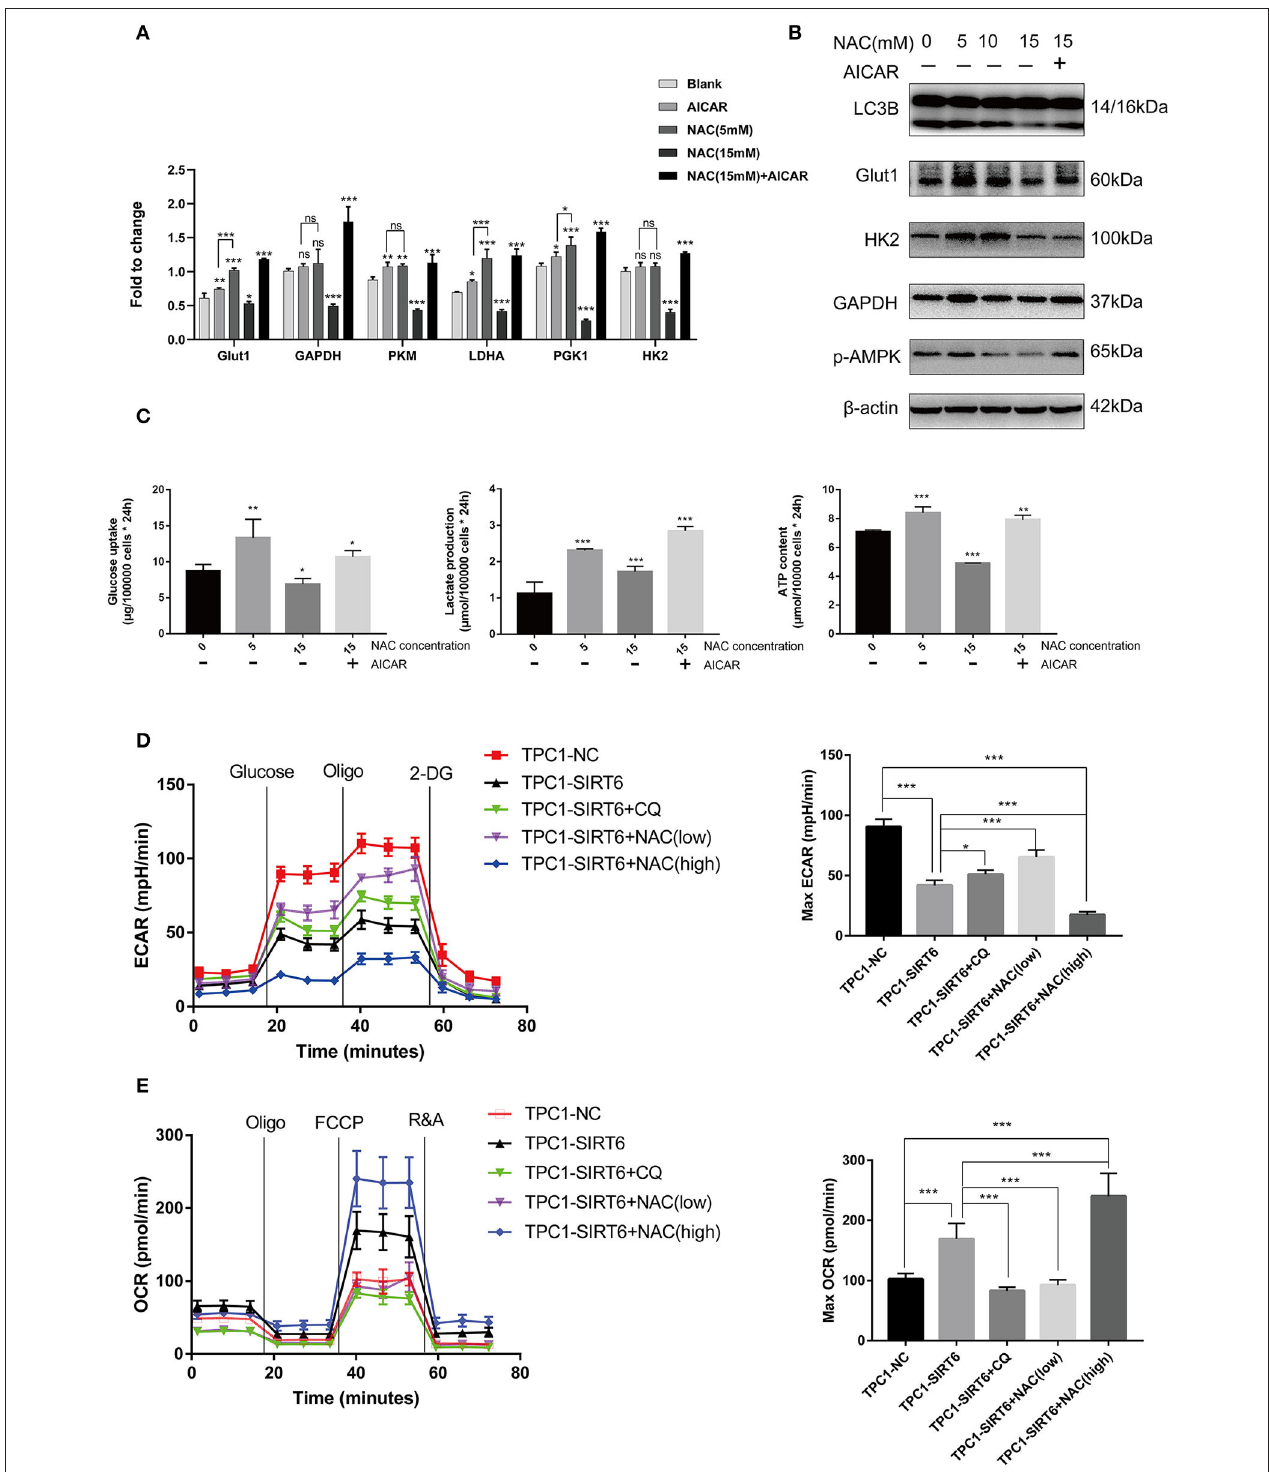
FIGURE 4 | A higher level of inhibition of ROS production restrained the Warburg effect by suppressing the AMPK pathway. (A) The mRNA expression of Warburg effect-associated genes (GLUT1, GAPDH, PKM, LDHA, PGK1, and HK2) in TPC1-SIRT6 cells treated with different concentration of NAC (0, 5, or 15mM for 3h) and the AMPK pathway activator AICAR (2mM for 3h). (B) Levels of proteins associated with the Warburg effect (GLUT1, HK2, and GAPDH), LC3B, and p-AMPK in TPC1-SIRT6 cells treated with different concentrations of NAC and the AMPK pathway activator AICAR. (C) Glucose uptake, lactate production and